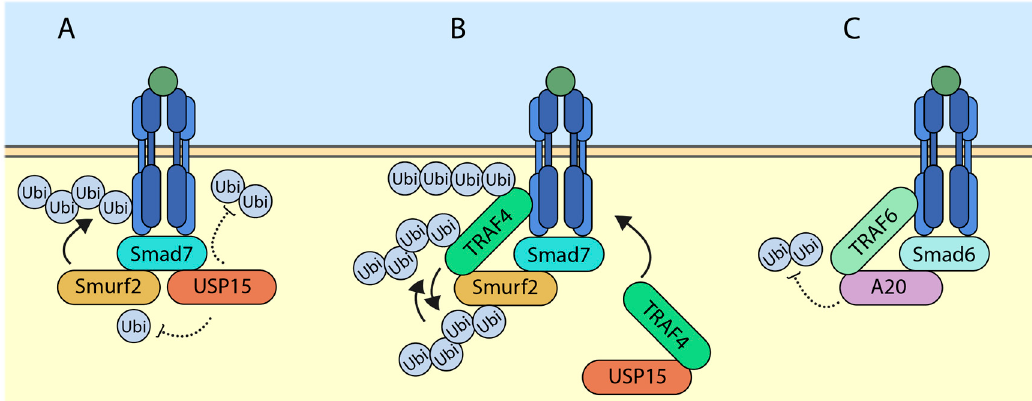
Figure 2. Ubiquitylating enzymes and deubiquitylating enzymes (DUBs) govern the outcome of TGF- β signaling. ( A ) USP15 deubiquitylates both TGF- β receptor and SMURF2 (SMAD ubiquitination regulatory factor 2) to enhance the signaling; ( B ) TRAF4 can either ubiquitylate itself or SMURF2 forming different polyubiquitin chains, and it has been shown to recruit USP15 (Ubiquitin-specific protease 15) to the receptor; ( C ) SMAD6 recruits A20 to the receptor which deubiquitylates TRAF6 and attenuates the signaling. Arrows indicate addition and dotted lines indicate removal.